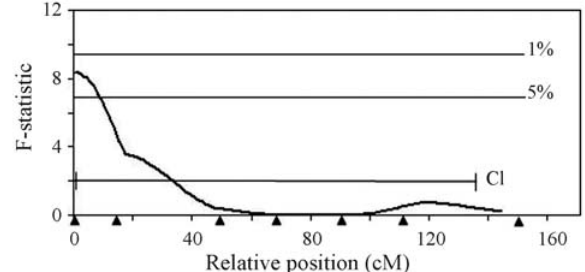
Figure 2 - Chromosome F-statistic distribution for the weight at 60 days quantitative trait locus (QLT) on the chromosome 14 (BTA14). The ar- rows below the X axis indicate marker positions on the chromosome as measured from the centromere, in centimorgans (cM): CSSSM066 (0.0 cM), ILSTS011 (16.9 cM), BMC1207 (47.8 cM), BMS740 (67.7 cM), BMS1899 (91.6 cM), BL1036 (116.8 cM) and BMS2055 (144.3 cM). The upper and lower horizontal lines represent threshold lev- els of 1% (F = 9.61) and 5% (F = 6.98). The QTL is located at 0.0 cM from the centromere (F = 8.34). The scale indicates the 95% confidence interval (0.0 cM to 137.5